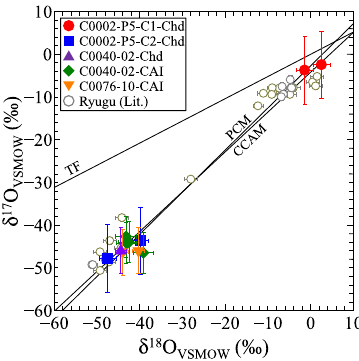
Fig. 3 | Oxygen three-isotope ratios of three chondrule-like objects and two CAIs in the Ryugu samples. TF, PCM, and CCAM represent the Terrestrial Frac- tionation line, the Primitive Chondrule Mineral line, and the Carbonaceous Chon- drite Anhydrous Mineral line. Literature data of isolated olivine and pyroxene